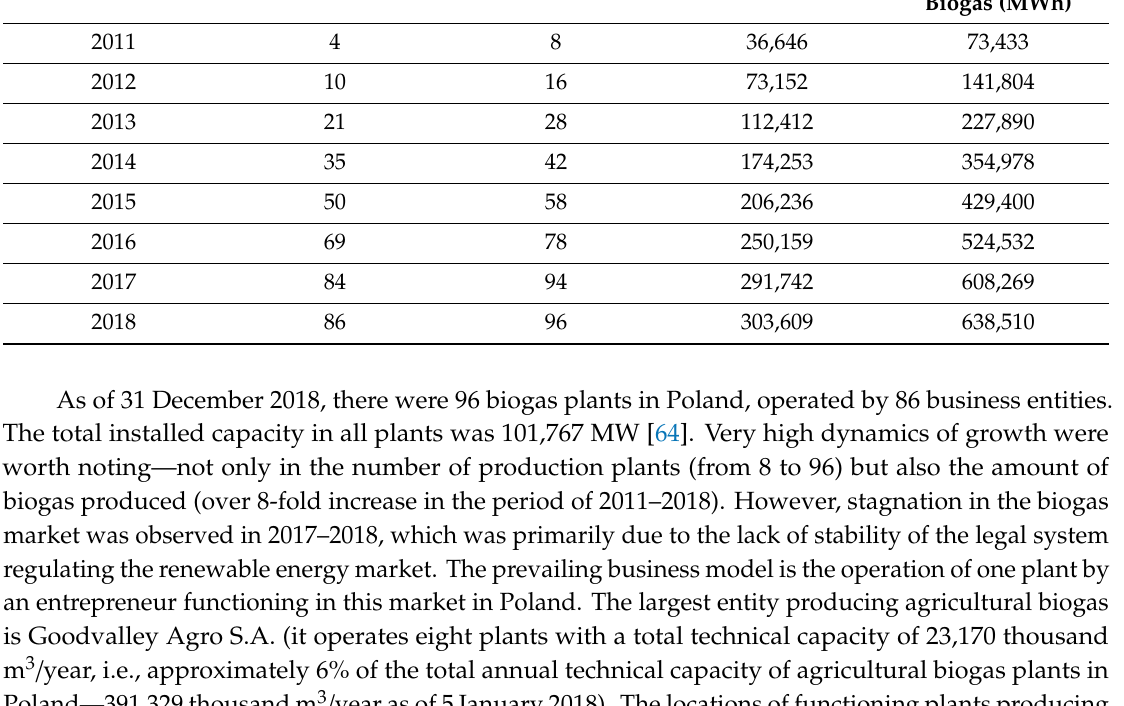
Table 1. Basic data were characterizing the number of entities dealing with the production of agricultural biogas in Poland in 2011–2018 and the volume of this production [64]. The Amount of The Amount of Electricity The Number of The Number of Agricultural Generated from Year Entities Entered Plants Included in Biogas Produced Agricultural into the Register the Register (thousand m 3 ) Biogas